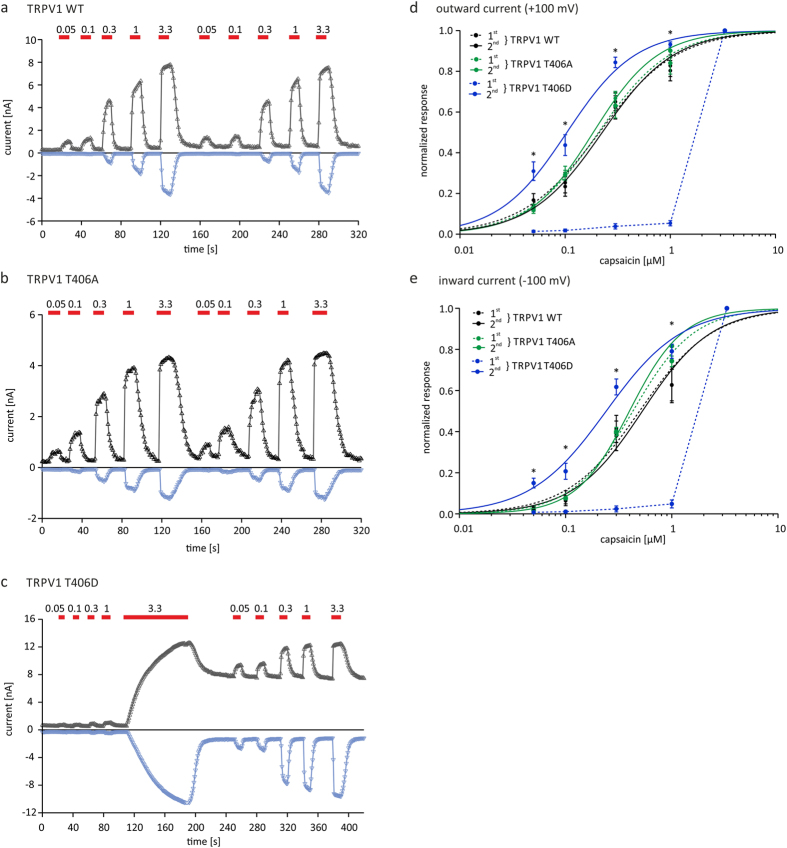
Sensitivity of TRPV1 to capsaicin is altered in the T406D mutant.Analysis of TRPV1 concentration/response-relationships in transiently transfected CHO cells using voltage-ramp protocols in the absence of extracellular Ca2+. Inward and outward currents of TRPV1WT (a), TRPV1T406A (b) and TRPV1T406D (c) induced by 0.05, 0.1, 0.3, 1 and 3.3 μM capsaicin. Concentration/response-relationships of outward (d) or inward (e) currents of TRPV1WT and TRPV1T406A show no difference between first and second series of application. Before priming of TRPV1T406D with 3.3 μM capsaicin, responses were small and not evaluable. Challenging cells with capsaicin (3.3 μM) led to significant increase in sensitivity and allowed the TRPV1T406D receptor to then respond to lower concentrations (paired t-test, p < 0.05). EC50 values obtained during the second series of capsaicin application (outward: TRPV1WT 0.28 ± 0.06 μM; TRPV1T406A 0.19 ± 0.02 μM; TRPV1T406D 0.11 ± 0.01 μM; inward: TRPV1WT 0.66 ± 0.14 μM; TRPV1T406A 0.40 ± 0.07 μM; TRPV1T406D 0.26 ± 0.03 μM). n = 6–10 independent measurements were performed for each receptor variant.